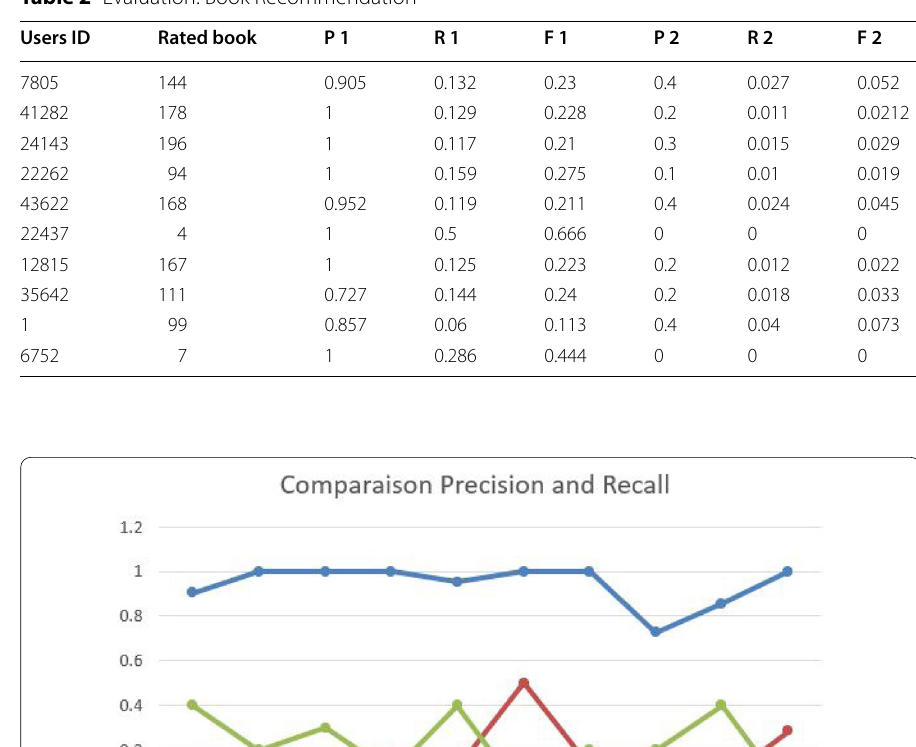
Table 2 Evaluation: Book Recommendation